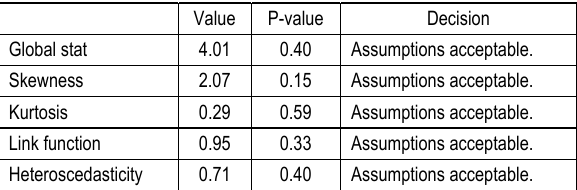
Table 9. Global test of log-log OLS